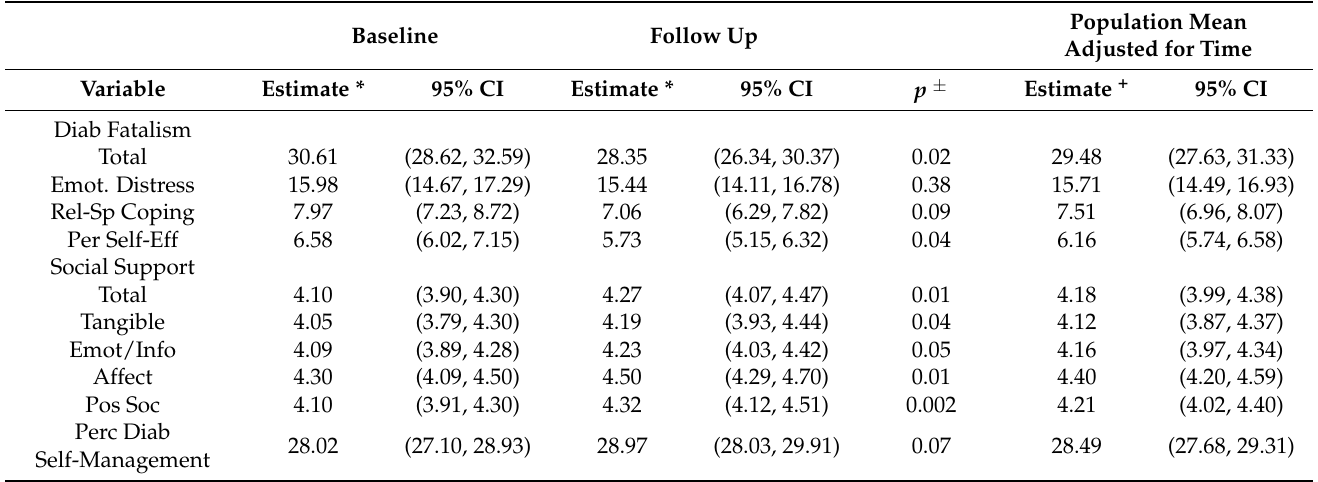
Table 3. Estimates * of population means pooled across study